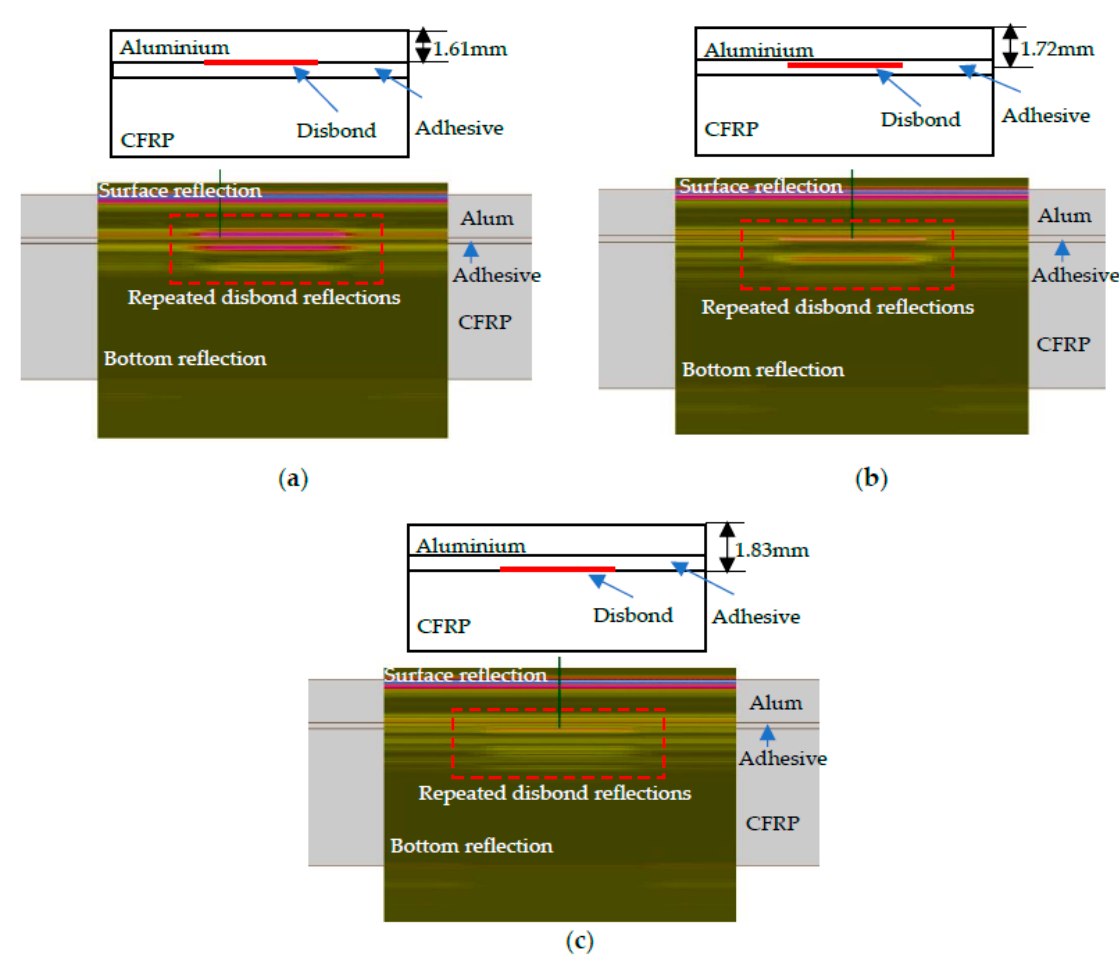
Figure 3. Disbond location and B-scans of the inspection simulation: ( a ) Disbond location between aluminum/adhesive; ( b ) Disbond location in the middle of the adhesive layer; ( c ) Disbond location between adhesive/composite.